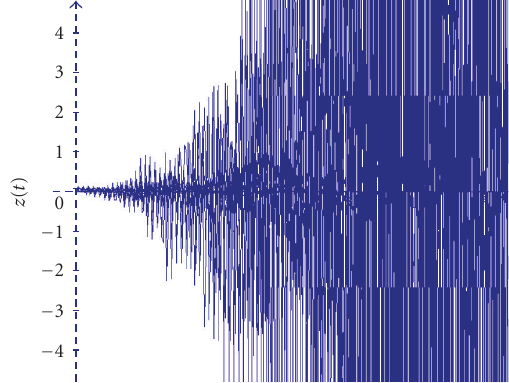
Figure 7.3 . Unstable solution of (5.2) in the point W (120,100), a 0 = 0 . 1.